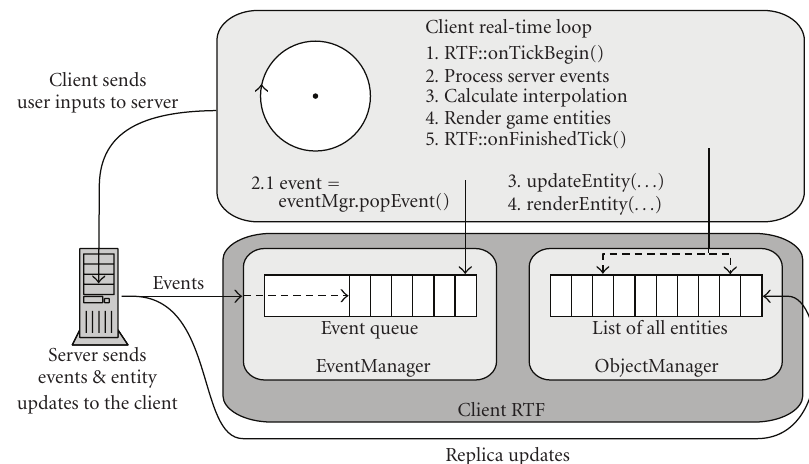
Figure 9: Client side game state processing integration with